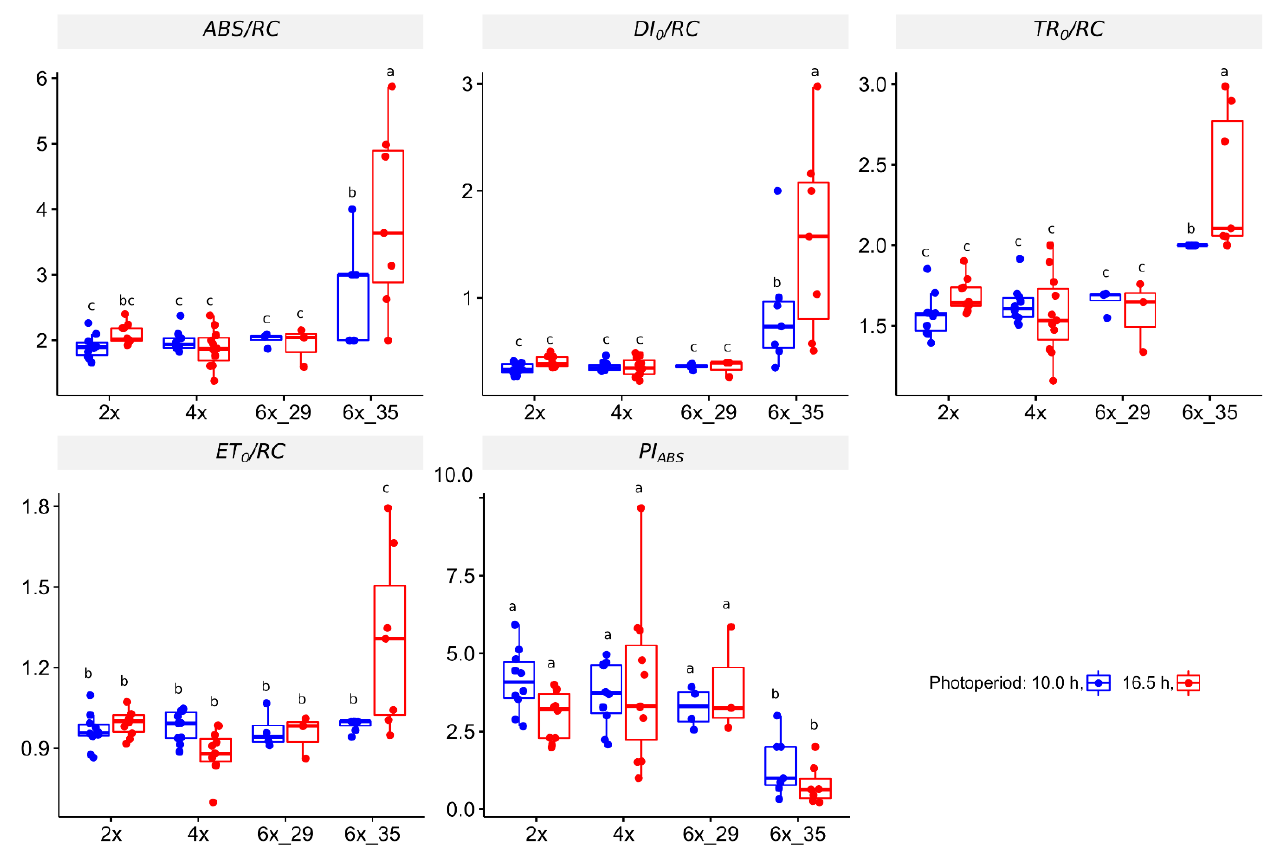
Figure 3. Coefficients calculated from fluorescent transient (OJIP) analysis of R. auricomus cytotypes exposed to two different photoperiods; absorption energy flux per PSII center ( ABS/RC ), dissipated energy fl. ( DI 0 /RC ); trapper energy fl. ( TR 0 /RC ); electron transport fl. ( ET 0 /RC ); performance index on absorption basis related to PSII activity ( PI ABS ); for summary statistics, see Table S4, letters represent 95% Duncan. Boxplots show the 25th, median, and 75th percentile range, and jitter plots represent the exact data distribution .